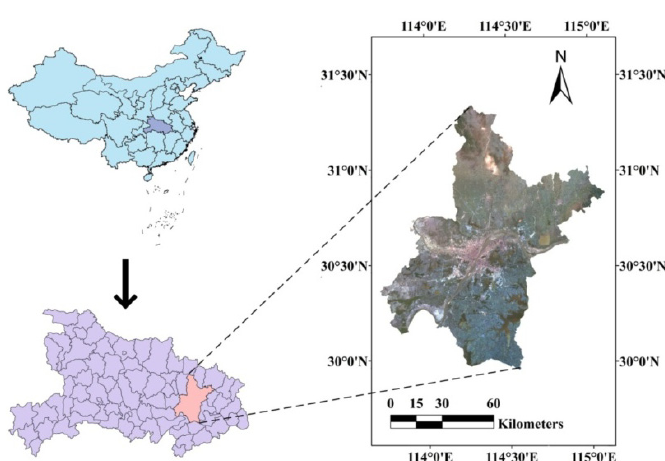
Figure 3. Location of Wuhan